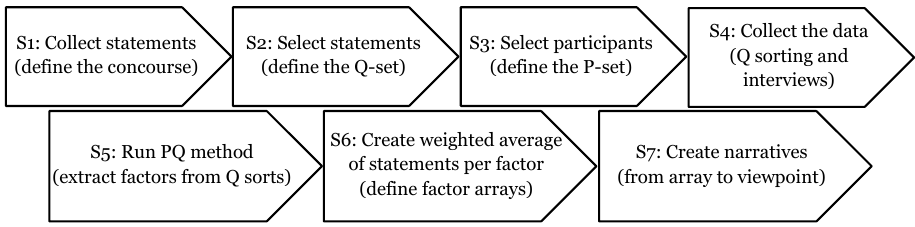
Figure 1. Flowchart of the steps of the Q methodological research approach. Based on Watts and Stenner (2012). For clarity reasons, we choose to describe Stage 5 in Watts and Stenner (2012) as three separate stages.